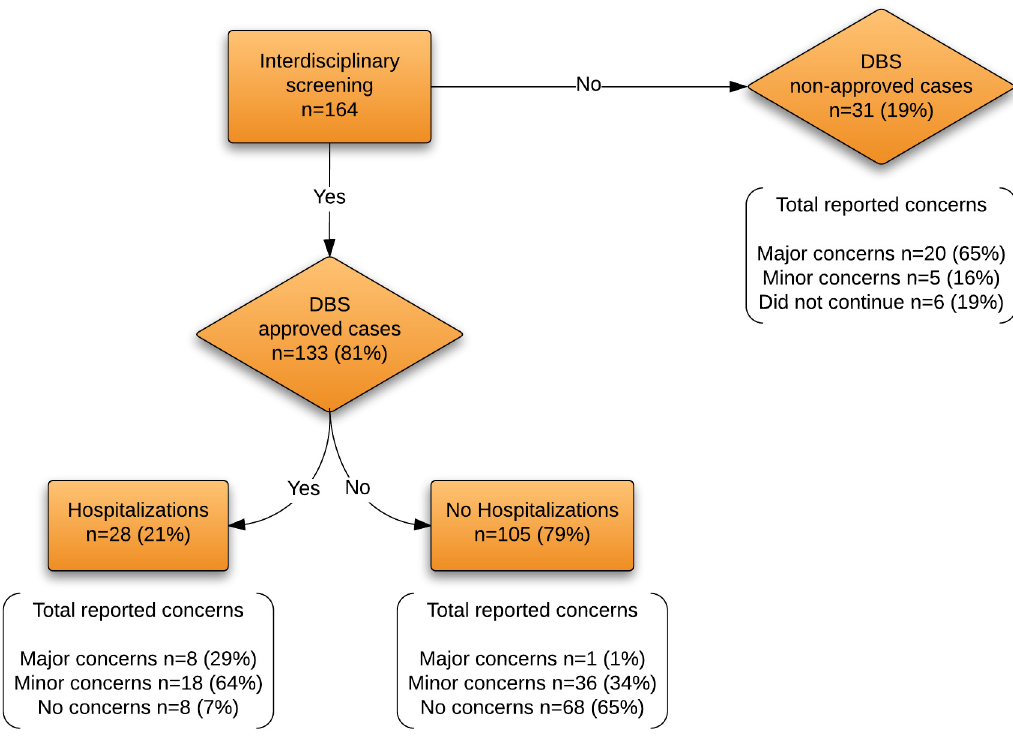
Fig 1. Number of patients per level of concern for those with and without